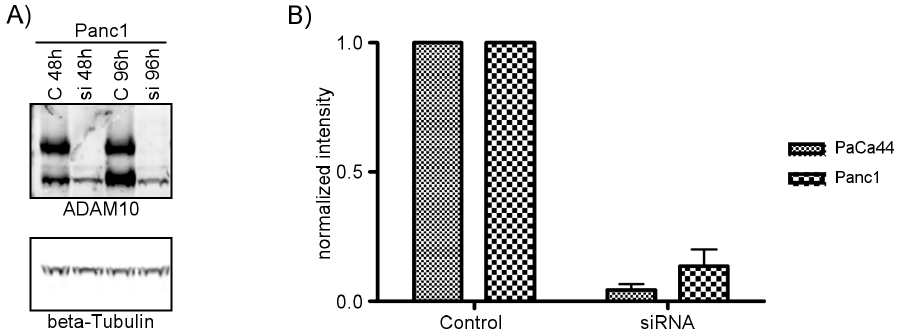
Figure 6. ADAM10 knockdown is efficient and stable for 96 h. ADAM10 expression was suppressed by siRNA mediated knockdown experiments using ADAM10-specific and control siRNA pool’s (30 m M each). A) Western blot analysis (75 m g of cell lysates) confirms efficient knockdown of B) Two independent experiments provided similar results as indicated by the normalized quantification.